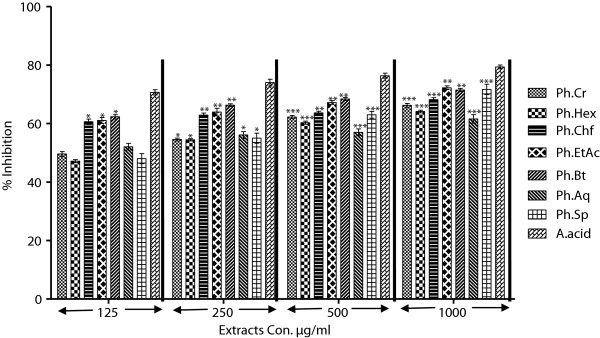
Antioxidant assay of plant extracts using DPPH assay. Values represent% radical scavenging (mean ± SEM) of three replicates. Values significantly different as compare to positive control, *P < 0.05, **P < 0.01, ***P < 0.001.